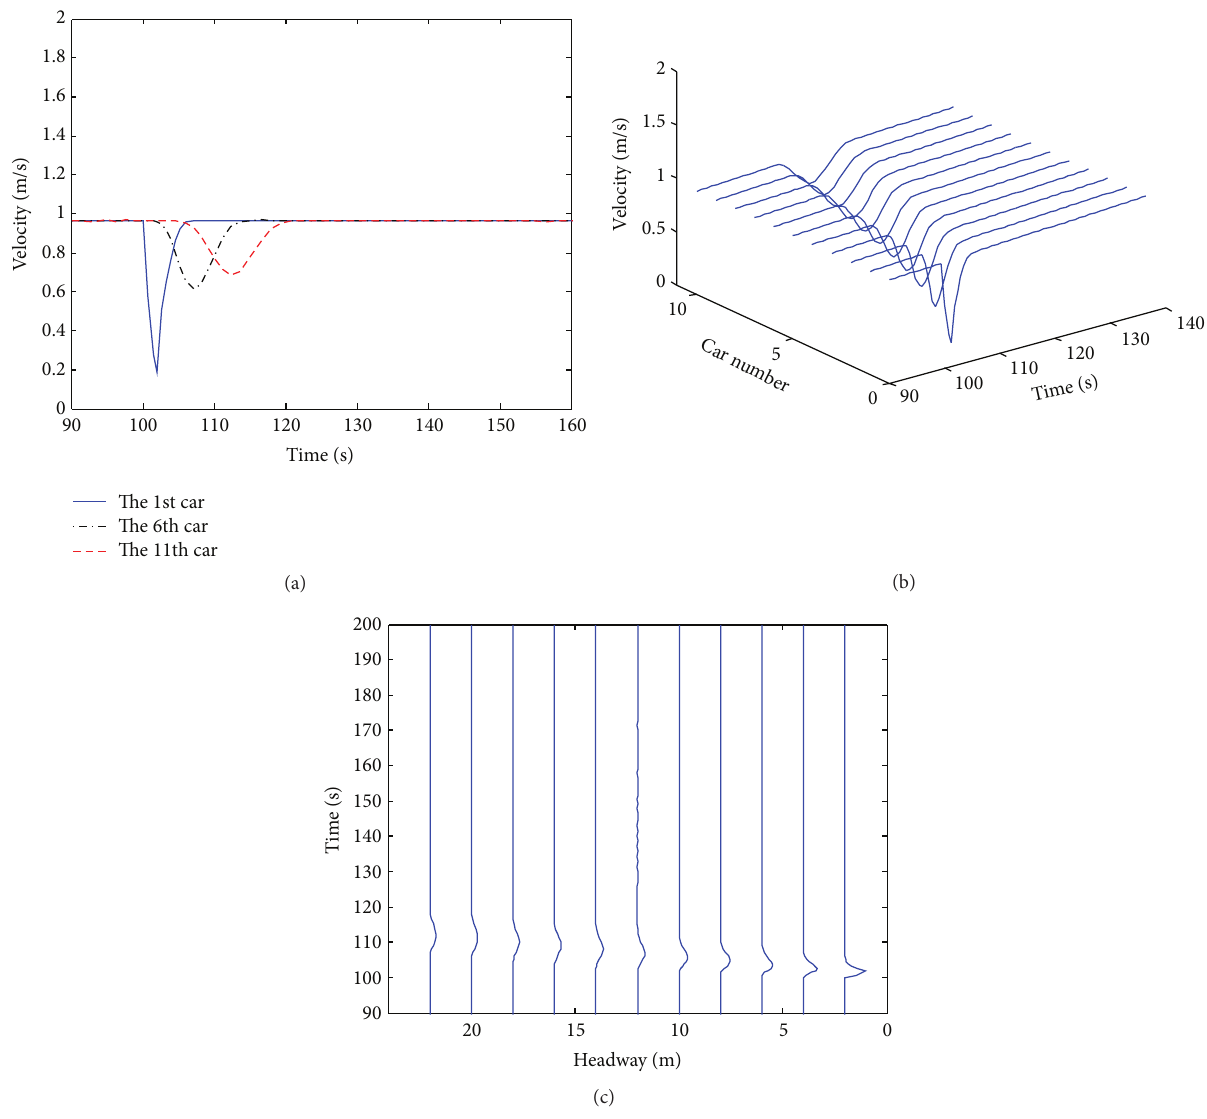
Figure 4: Car-following model under the fuzzy controller: (a) speed-time image of vehicles 1, 6, and 11, (b) speed-time image of all vehicles, and (c) headway-time